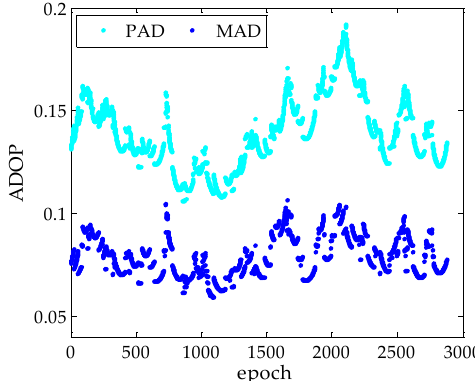
Figure 2. ADOP for the PAD and MAD methods.